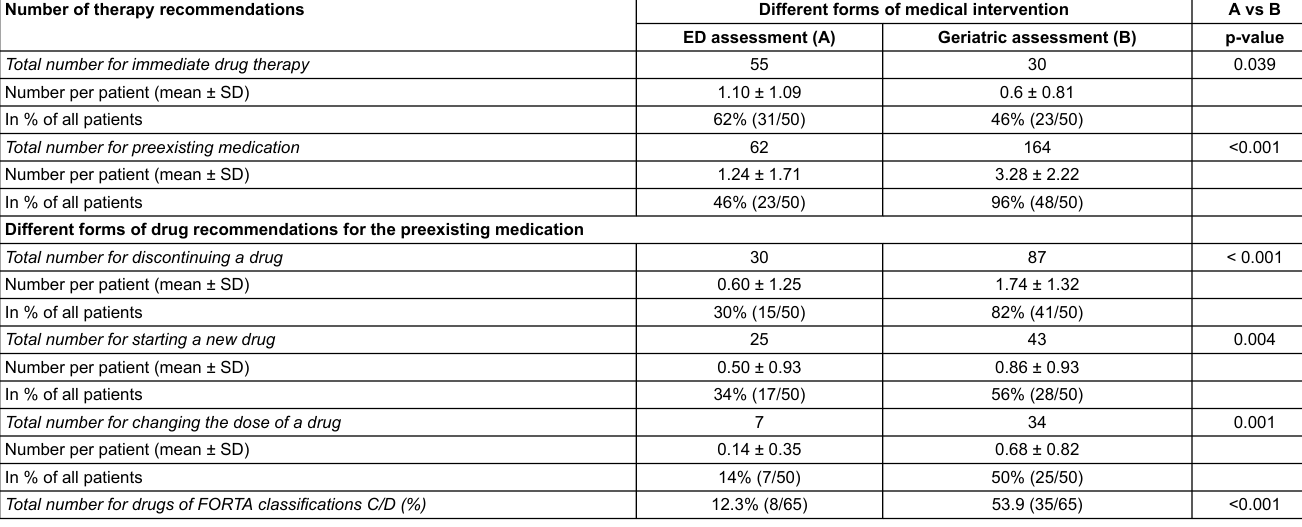
Table 1: Comparison of the different forms of pharmacological recommendations between geriatric and ED assessment. The table shows (1) the total number of drug recom- mendations, (2) the number of recommendations per patient, and (3) the number of affected patients for each form of therapy recommendation. With regard to the FORTA C/D drugs, only the number of recommendations in relation to the total number of FORTA C/D drugs is